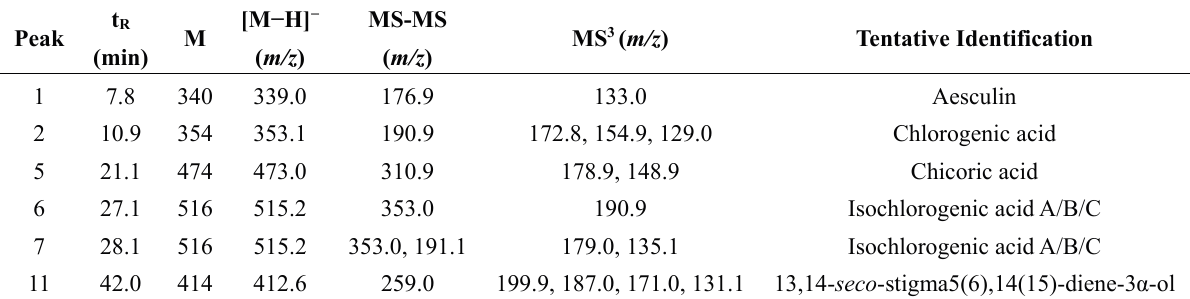
Table 3. Identification of effective components in chicory by HPLC-DAD-ESI-MS 3